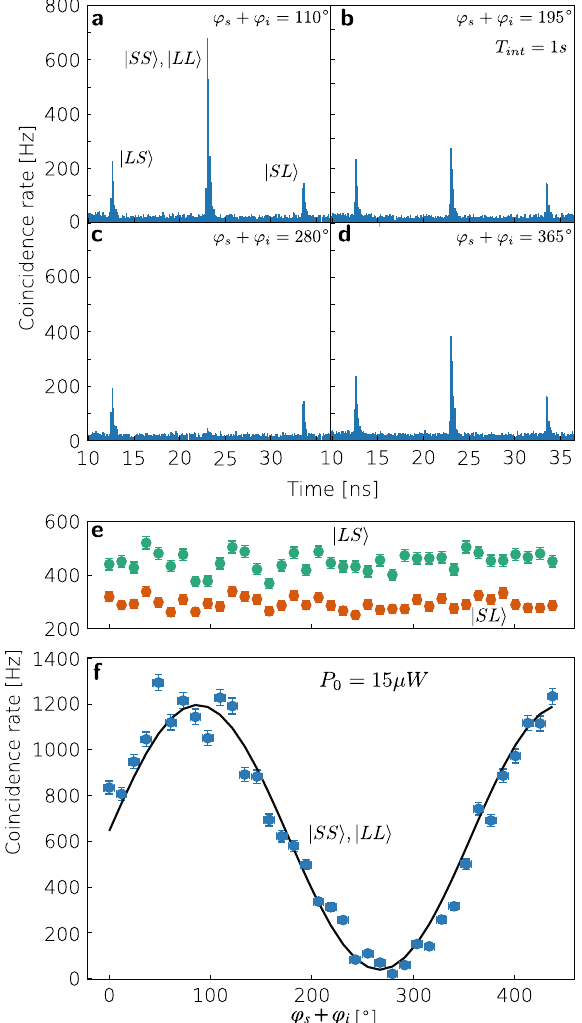
Fig. 3 Time-energy entanglement. a – d Coincidence histograms after T int = 1 s integration for different values of the phase acquired by the signal and idler photons in the interferometer φ s + φ i . The paths of the photons are shown in the fi rst histogram (S short and L long). e , f Coincidence rate for the side peaks (green and red circles) and for the central peak (blue circles), respectively, as a function of φ s + φ i . The black curve is fi tted with a sinusoidal function to extract the visibility of the fringes caused by two- photon interference. This measurement is obtained for P 0 = 15 μ W of pump power. Vertical error bars refer to the standard deviation of a Poisson distribution and horizontal ones to uncertainty on the photon pair phase. (cid:3) (cid:4) ffiffiffi p (cid:3) ¼ ð SS j i þ exp ½ i ð φ þ φ Þ(cid:3) LL j iÞ = 2 , where φ s entangled state ψ s i